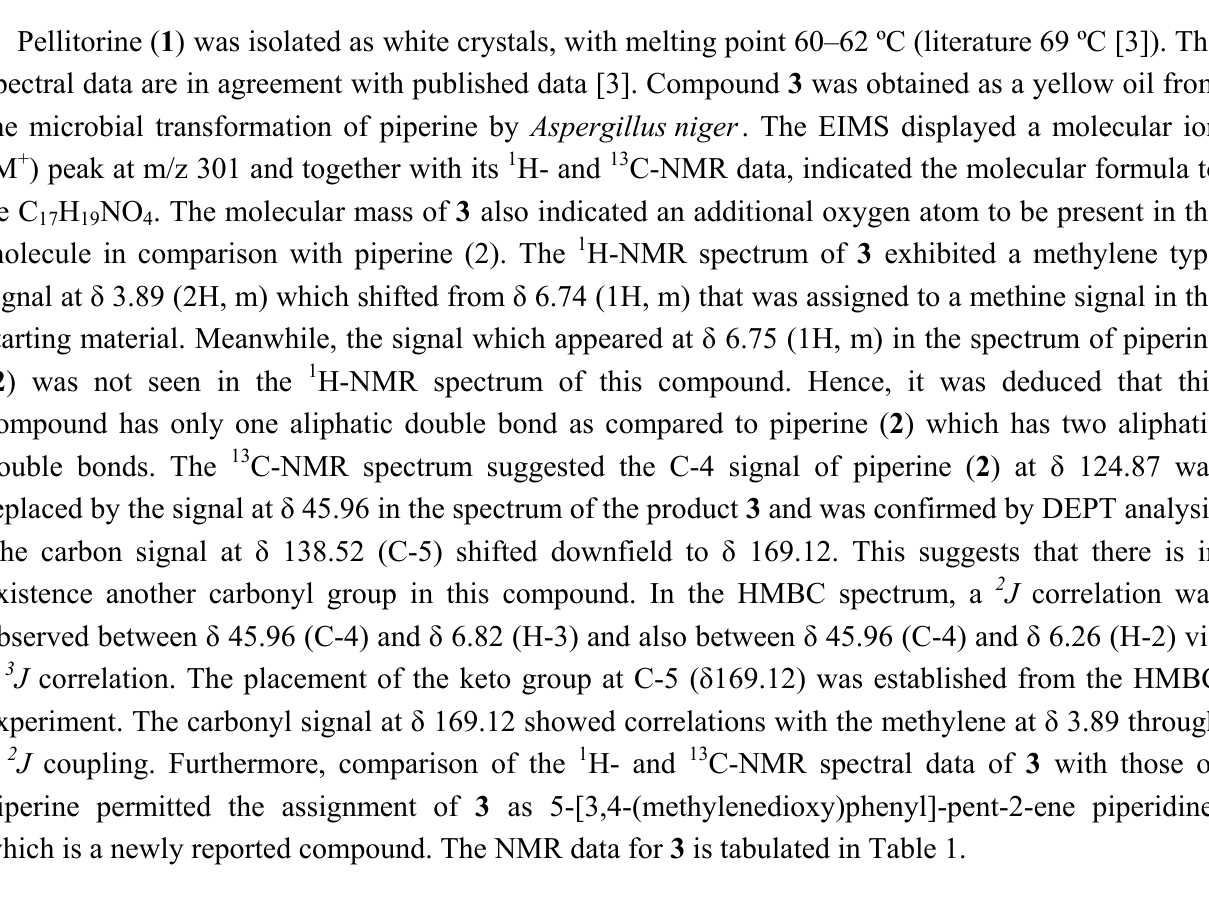
Table 1. NMR data for 3